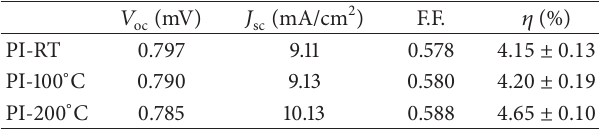
Table 1: Values of open-circuit voltage ( 𝑉 ),fillfactor(F.F.),andefficiency( 𝜂 )forsolarcellswithRT- density( 𝐽 sc deposited, 100 ∘ C-deposited, and 200 ∘ C-deposited GZO thin